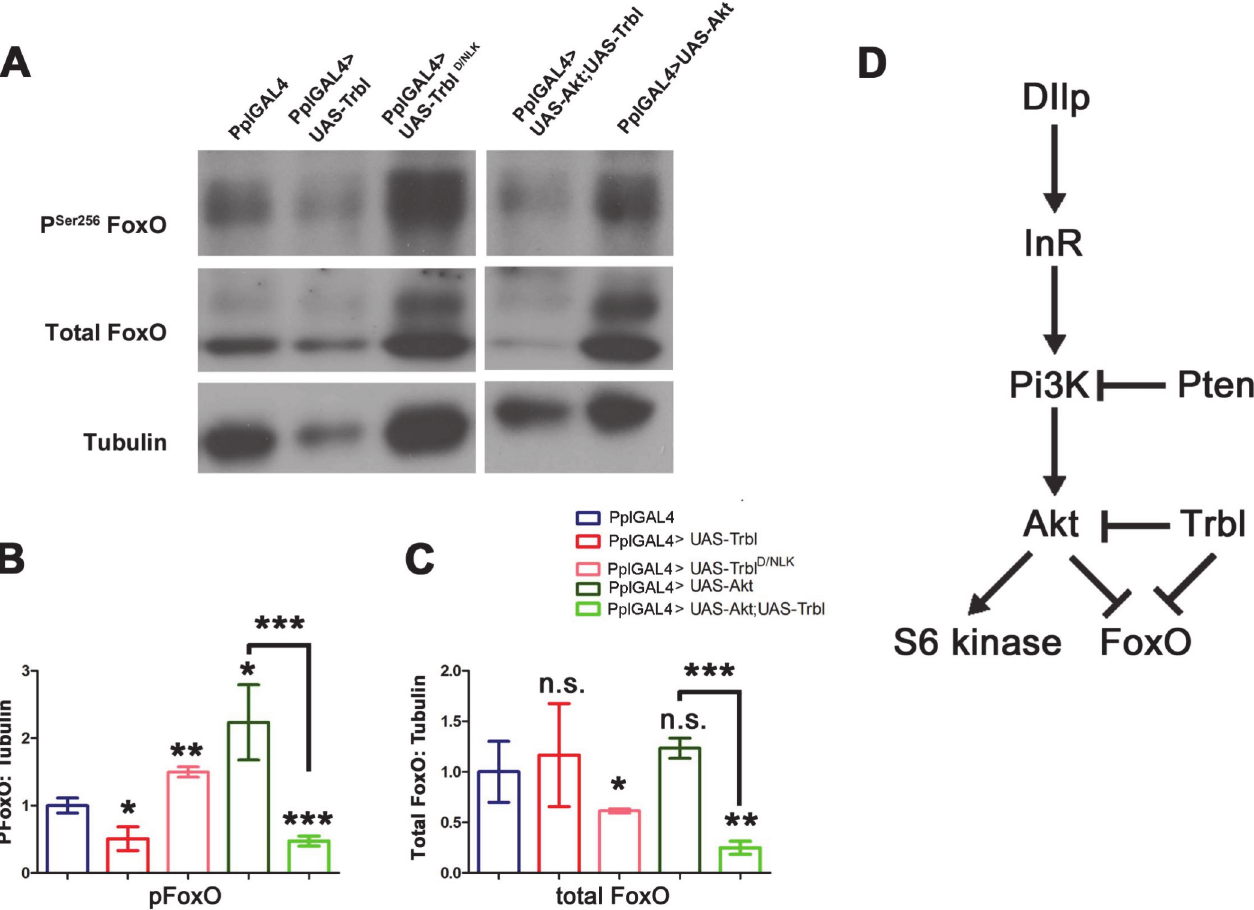
Fig 7. Trbl reduces FoxO phosphorylation; a model for Trbl action. (A). Representative Western blot of fat body extract from age matched 3 rd instar larvae driving transgene expression by PplGAL4. Equal amount of fat body extract was loaded in each lane. Tubulin blot picture is same as Fig. 5A because the same blot was stripped and reprobed as described in materials and methods. See text for details. (B,C). Quantification of western blots of fat body extracts from four independent experiments (n = 4) showing the effect of Trbl and Trbl D/NLK on FoxO phosphorylation and total FoxO levels. See text for details. For all quantification, α -tubulin was used as loading control and results were normalized to PplGAL4; P values from one-way ANOVA and two-tailed T test data are indicated (n.s. = not significant; * P < 0.05; ** P < 0.01; *** P < 0.001) and are summarized in Table S1 and all error bars are ± S.D. (B). PSer 256 FoxO. (C). Total FoxO. (D). Model for Trbl regulation of Akt and FoxO. See text for